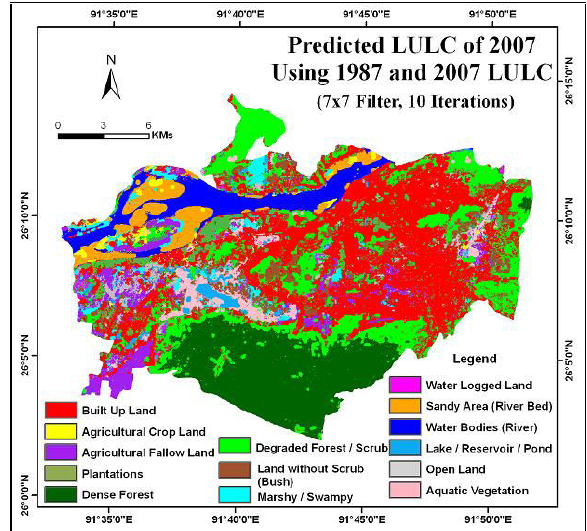
Figure 9. Predicted LULC of 2007 using 1987 & 1997 LULC image (7x7 contiguity filter, 10 iterations)